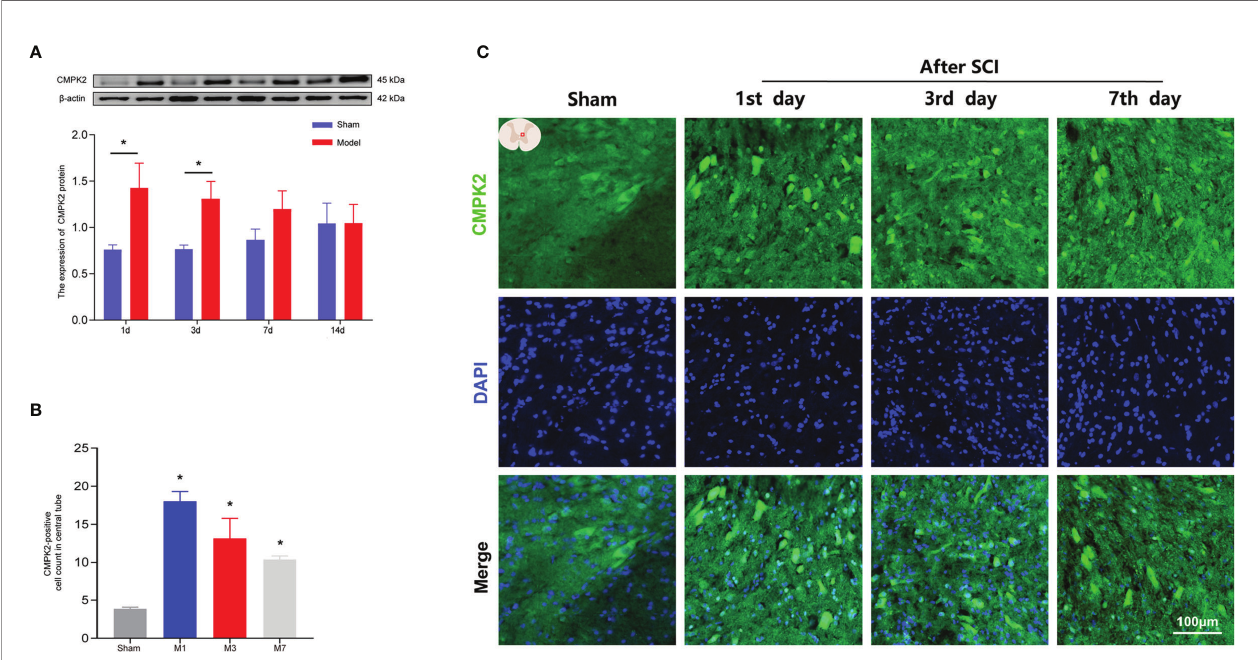
FIGURE 5 | The expression of CMPK2 in rat spinal cords was detected using WB and IF. (A) Western blotting was used to analyze the protein expression of CMPK2 in the sham and model groups after SCI. Representative protein bands are shown for CMPK at 1, 3, 7, and 14 days after SCI (N = 5 rats/group). *p < 0.05; two-way ANOVA was used for comparison. (B) Quantitative analysis of CMPK2-positive cells. *p < 0.05 compared with the sham group; one-way anOVA was used for comparison. N = 5 rats/group. (C) CMPK2 was expressed around the central canal of the gray matter of the spinal cord at 1, 3, and 7 days after spinal cord injury. CMPK2-positive cells are represented by green fl uorescence. DAPI (blue) co-staining was used to identify positive cells. Data are presented as the mean ± SEM. WB, Western blotting; IF, immuno fl uorescence; SCI, spinal cord